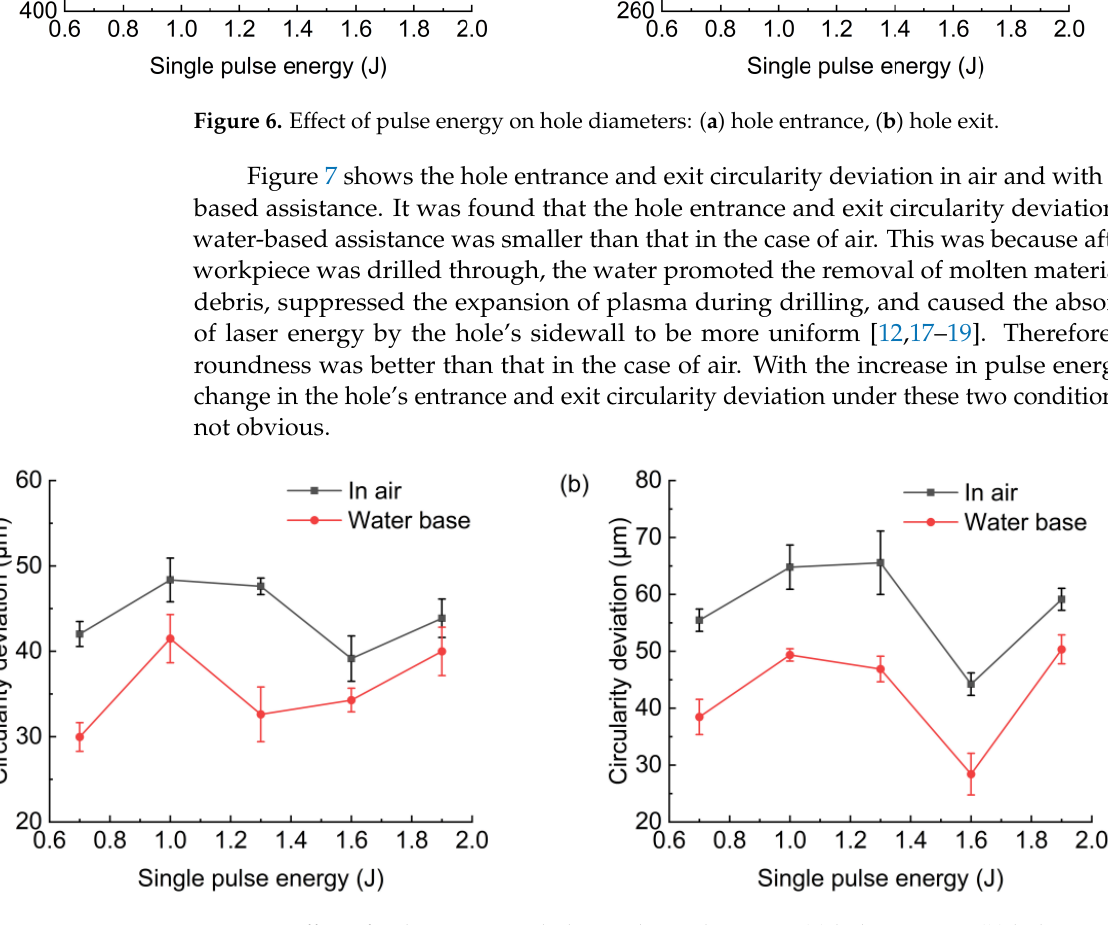
Figure 6. Effect of pulse energy on hole diameters: ( a ) hole entrance, ( b ) hole exit.